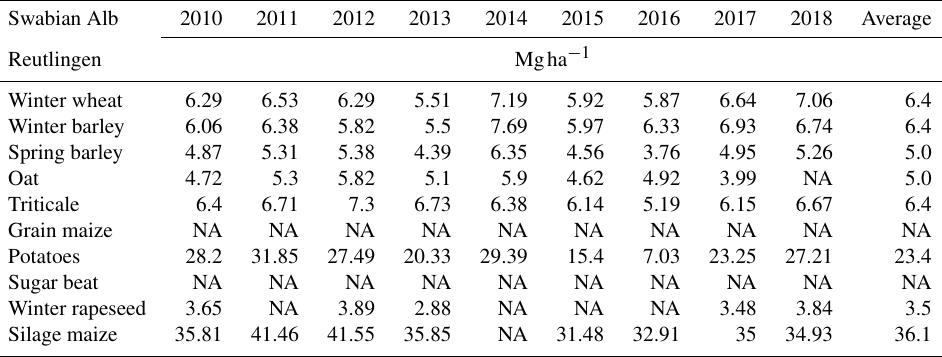
Table B3. Average yields of the Swabian Alb district Reutlingen for the years 2010–2018. Values that are not available are indicated by NA. Data from Statistisches Landesamt Baden-Württemberg accessible at https://www.statistik-bw.de/SRDB/ (last access: 20 May 2020): Regionaldaten – Land- und Forstwirtschaft – Ernte – Hektarerträge der Feldfrüchte (Landkreis Enzkreis). Swabian